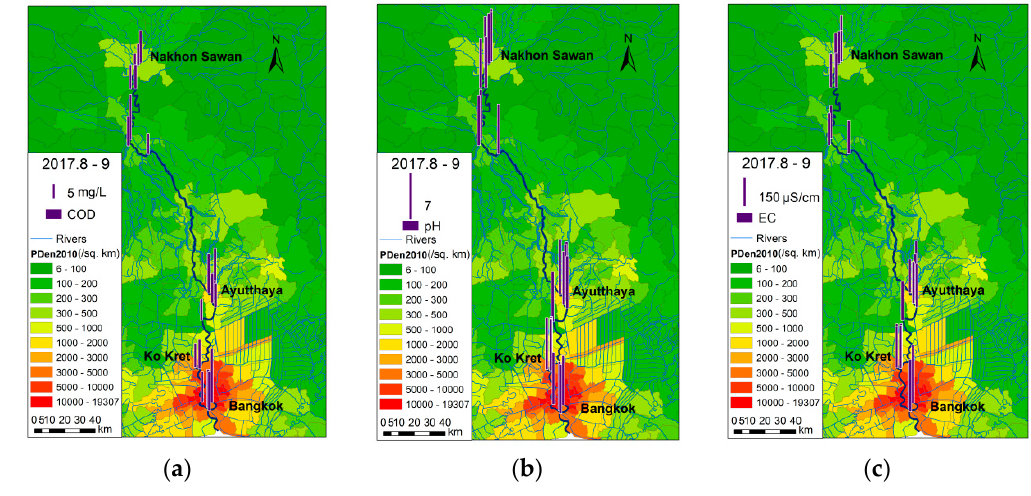
Figure 7. The spatial variations of COD ( a ), pH ( b ), and EC ( c ).